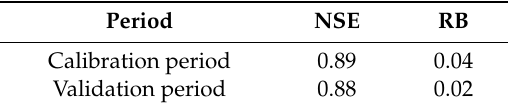
Table 1. GBHM performance of daily discharge simulation during the calibration and validation periods at Hengshan